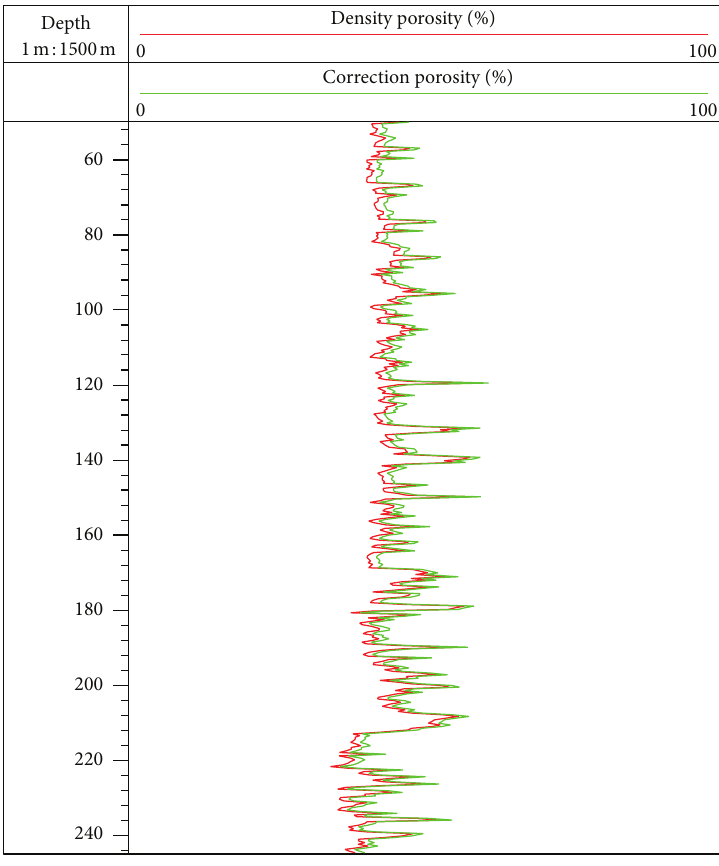
Figure 3: Result of sediment porosity calculated by density log data at site SH2. (Red line is the sediment porosity estimation used density log data; bright green line is the sediment porosity estimation which considered the effect of argillaceous